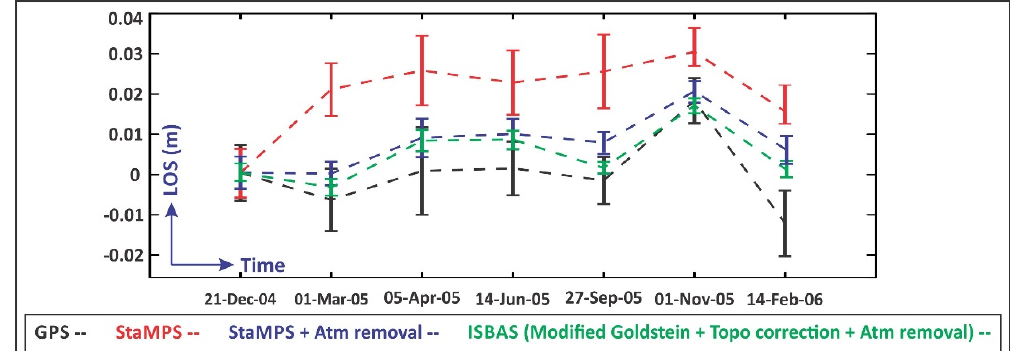
Figure 14. Comparison between GPS-derived LOS displacements and Envisat descending observations for PLOR